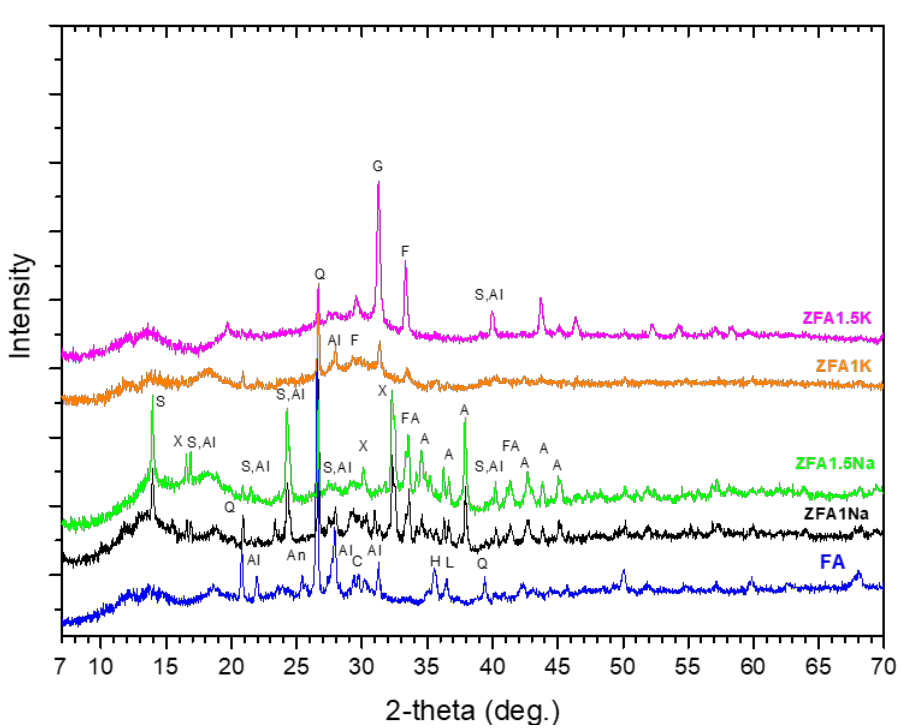
Figure 1. XRD patterns of FA, Na zeolites (ZFA1Na and ZFA1.5Na), and K zeolites (ZFA1K and Figure1. XRDpatternsofFA,Nazeolites(ZFA1NaandZFA1.5Na), andKzeolites(ZFA1KandZFA1.5K).